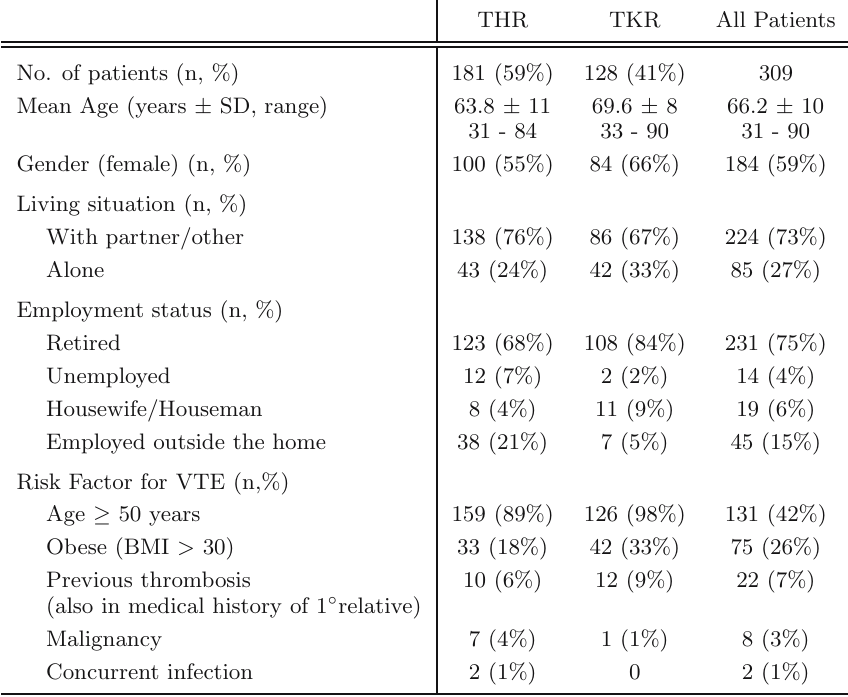
Table 2 Socio-demographics of patients and risk factors for thrombosis development.